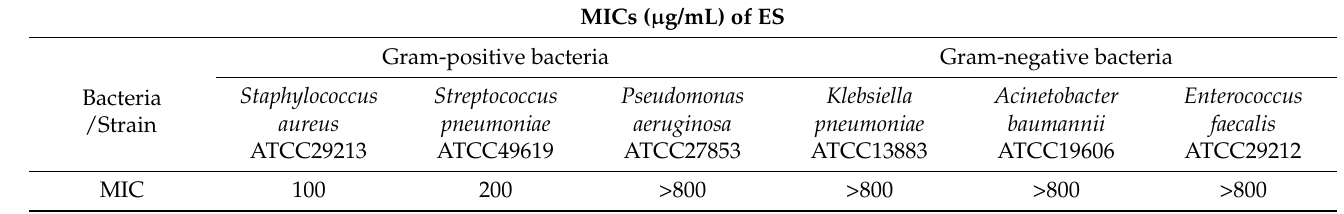
Table 1. Determination of MICs against Gram-positive and Gram-negative reference strains.